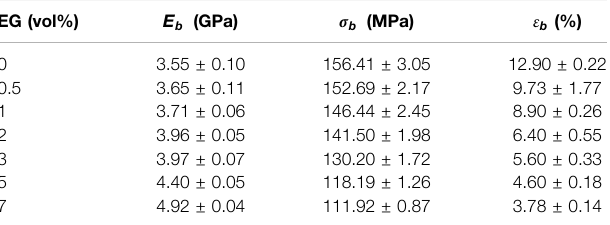
TABLE 3| Flexuralpropertiesofthecomposites: E b (cid:2) fl exuralmodulus, σ b (cid:2) fl exural strength, and ε b (cid:2) fracture strain. EG